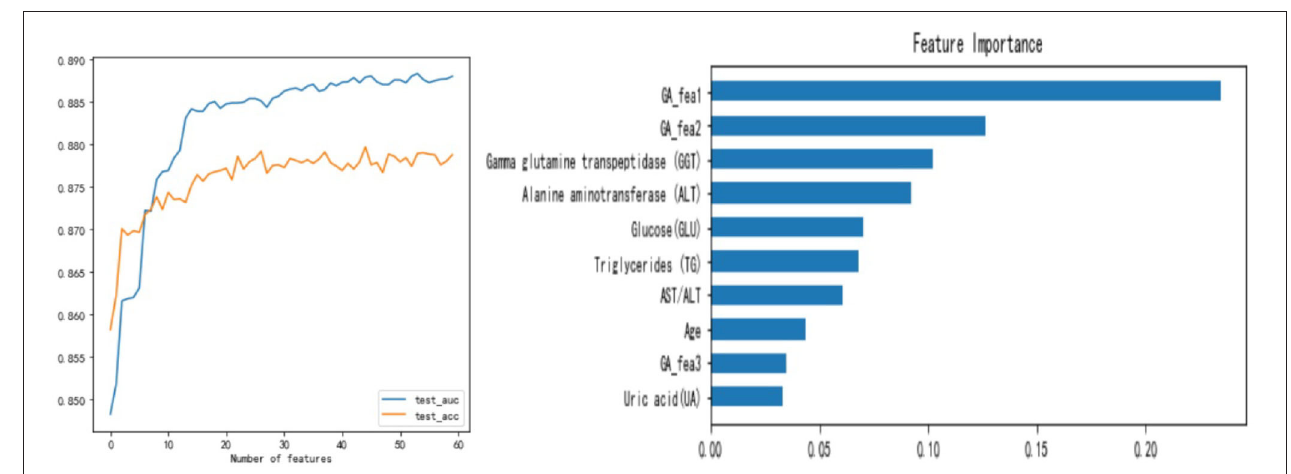
FIGURE 7 | The influence of the number of features used on the model and feature importance.